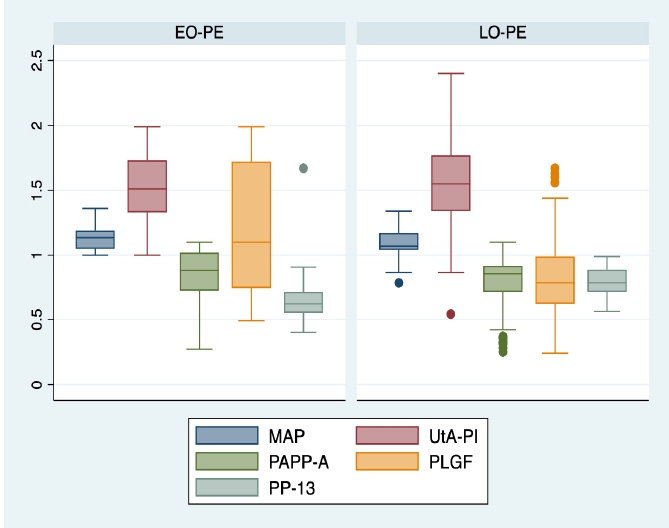
Figure 1. Boxplot representing the comparison of paraclinical parameters in subgroups 1 and 2. Legend: MAP—mean arterial pressure; UtA ‐ PI—uterine artery pulsatility index; PLGF—placental growth factor; PP ‐ 13—placental protein ‐ 13; PAPP ‐ A—pregnancy ‐ associated plasma protein ‐ A; EO ‐